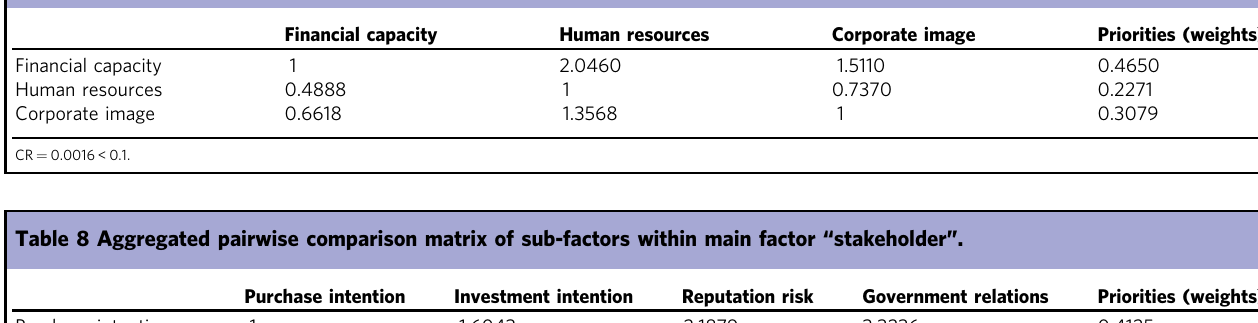
Table 7 Aggregated pairwise comparison matrix of sub-factors within main factor “ company ”